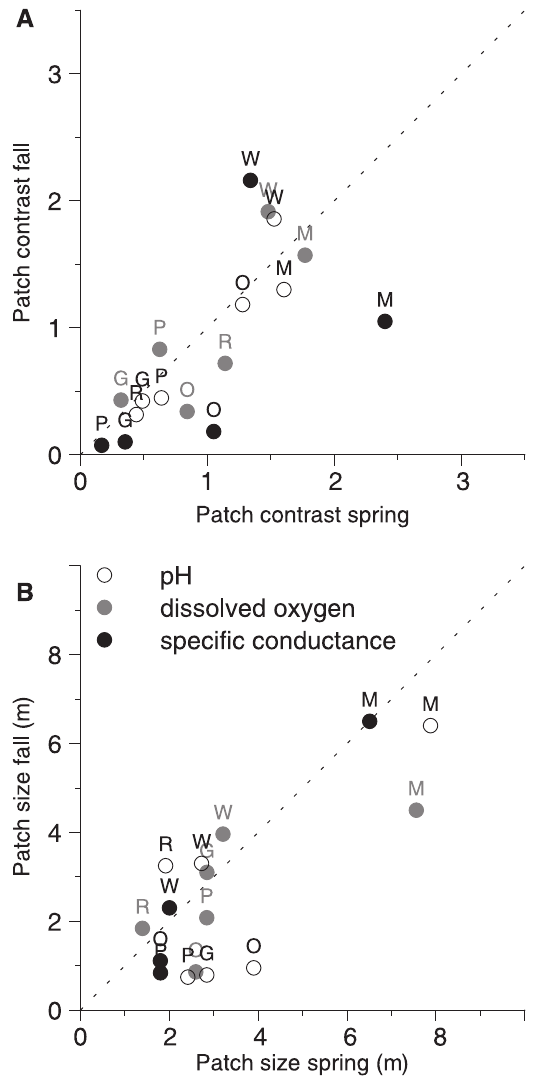
Figure 4. Results of geostatistical analysis: Patch contrasts and patch sizes. Results of the geostatistical analysis of all stream reaches at both dates of the development data: patch contrasts (A) and patch sizes (B) of hyporheic parameters. Dashed lines (y = x) indicate no temporal variation. Patch contrast is shown as normalized value, where 1 represents the mean for each parameter. Markers are coded with a capital letter for the stream reach. M = Moosach (without validation data), W = Wiesent, G = Guenz, O = Grosse Ohe, P = Perlenbach, R = Suedliche Regnitz.